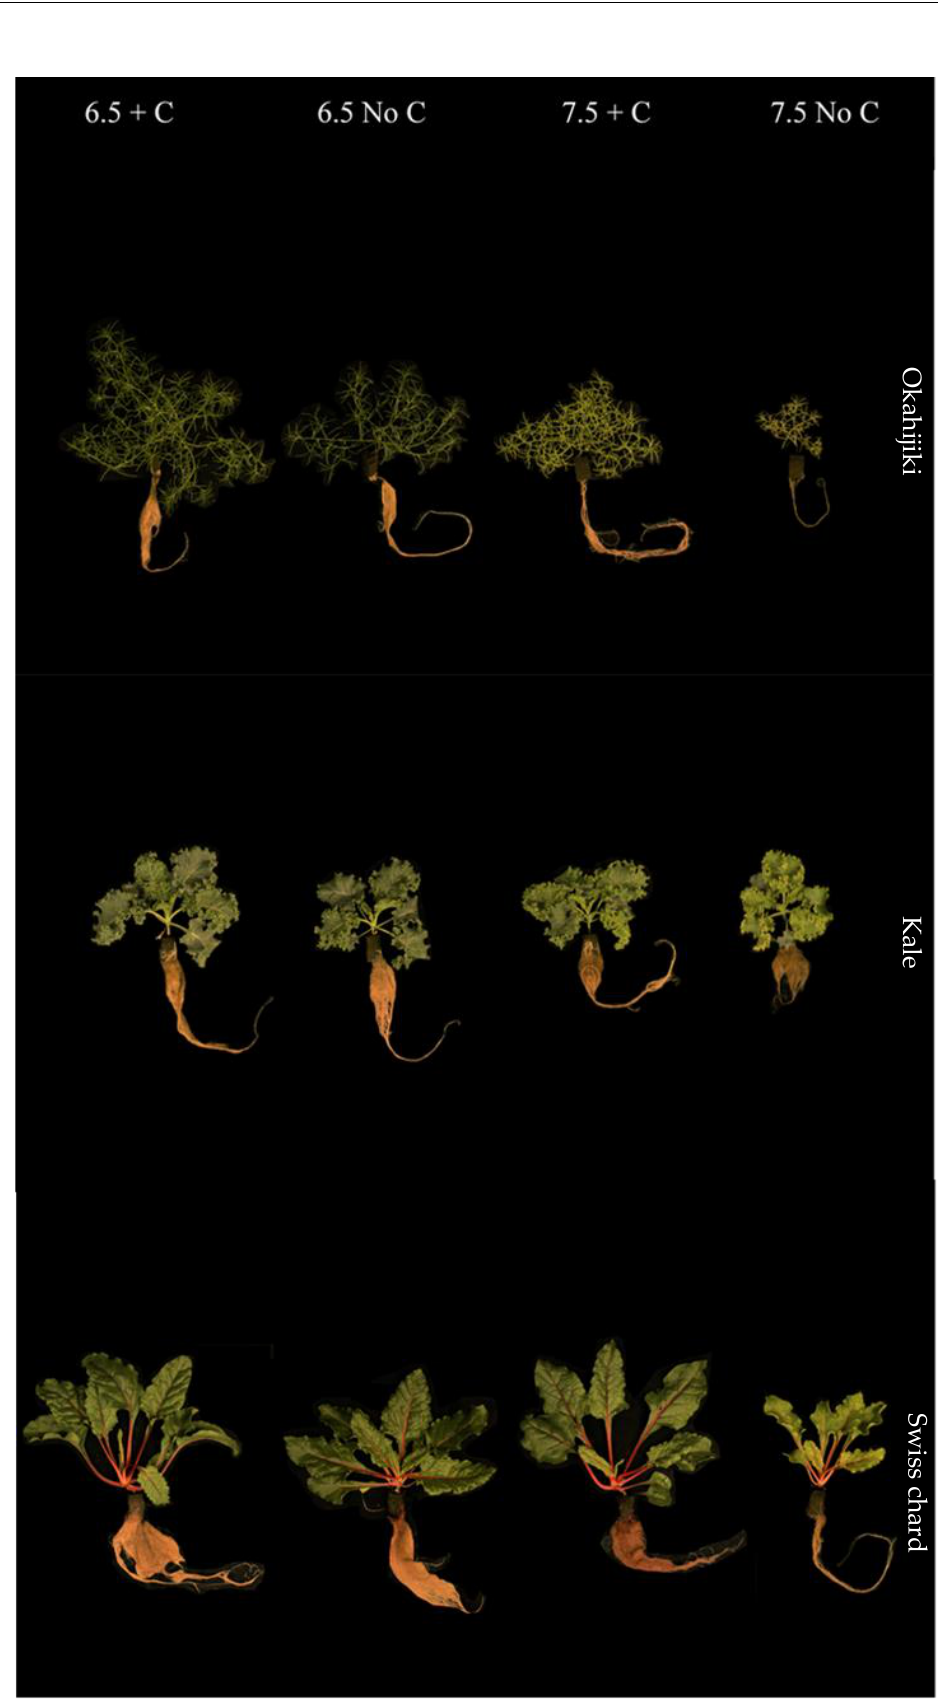
Figure 3. Plants harvested from the second 4 weeks. Both red orache and okahijiki were sensitive to higher pH and growth was enhanced by additional C. Plants grown in 6.5 + C treatment had significantly higher ( p < 0.05) growth (fresh weight, dry weight, plant height, RGR, and yield), SPAD value, and Fv/Fm.